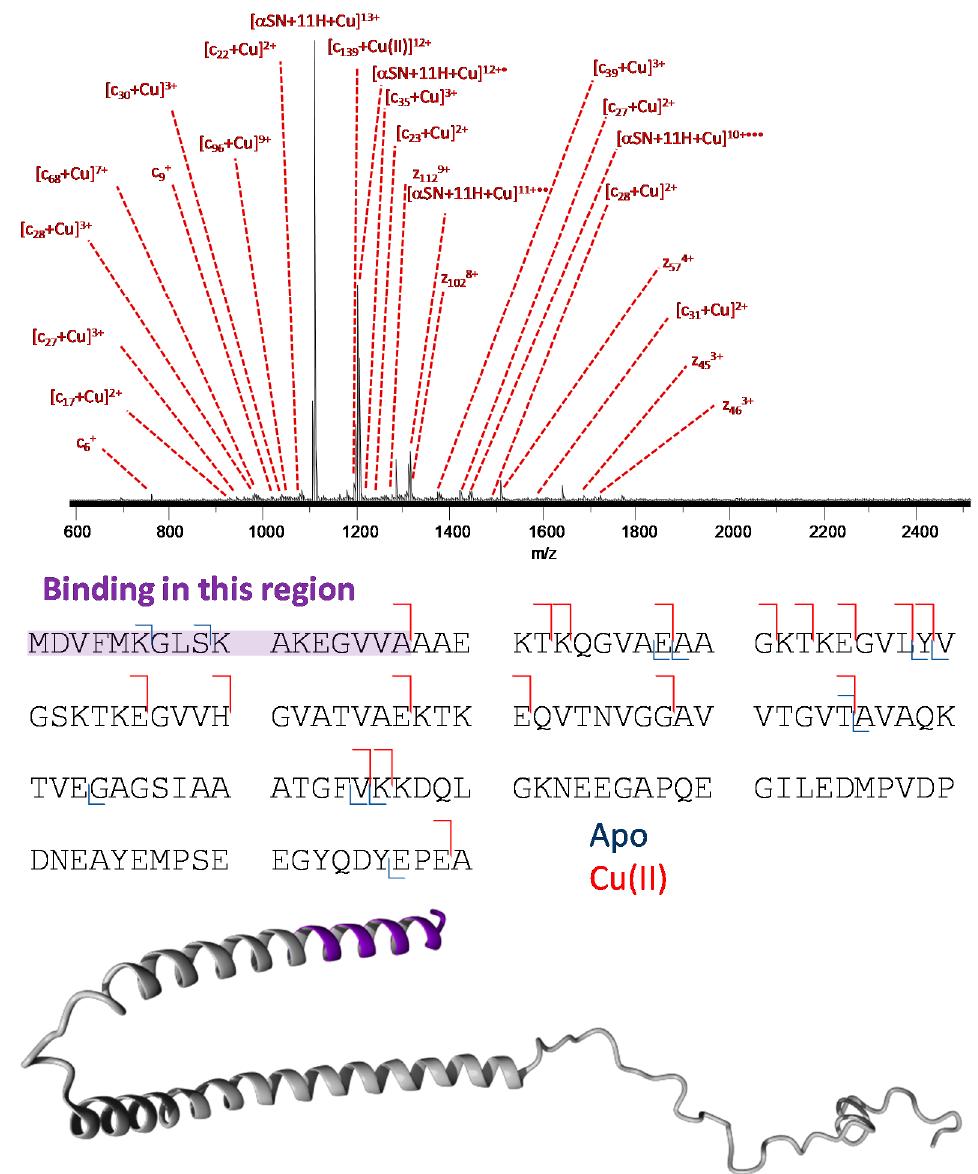
Figure A4. Tandem MS analysis of the [ α -syn + Cu(II)] complex, showing the results from electron capture dissociation (ECD) fragmentation of [ α -syn + 11H + Cu(II)] 13 + . The fragments are summarized below the mass spectrum, and the possible binding region is indicated. A 3D structural representation of α -syn is shown at the bottom, with the possible binding region colored purple.